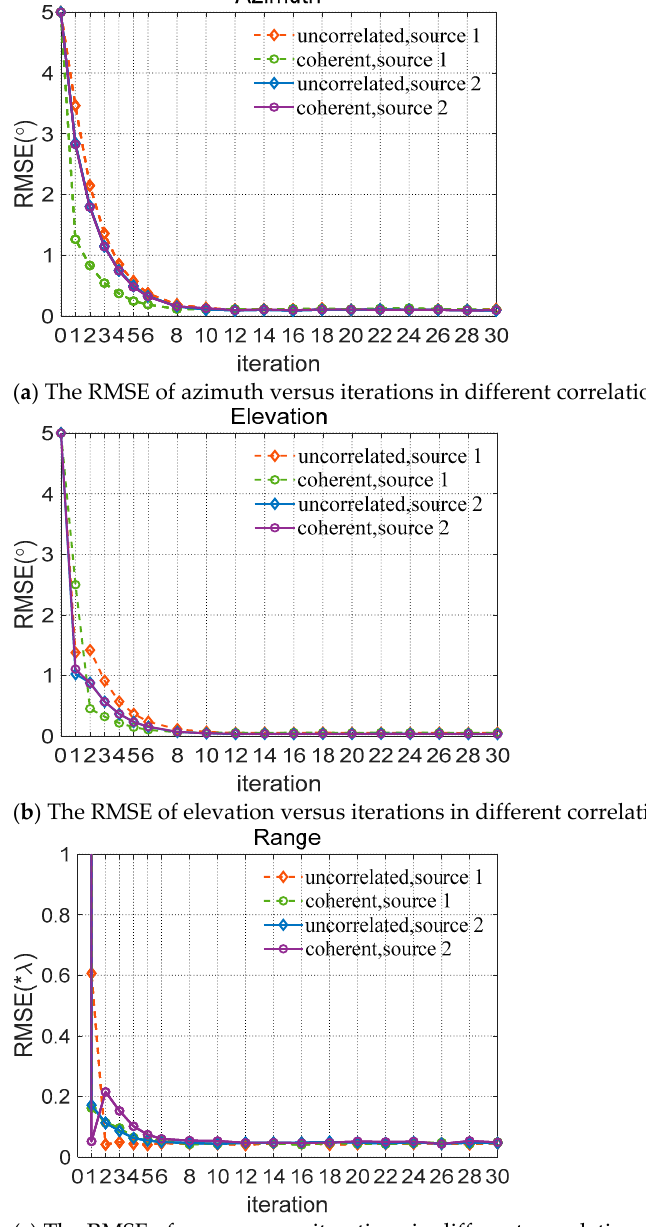
Figure 7. Convergence comparison of coherent signals.